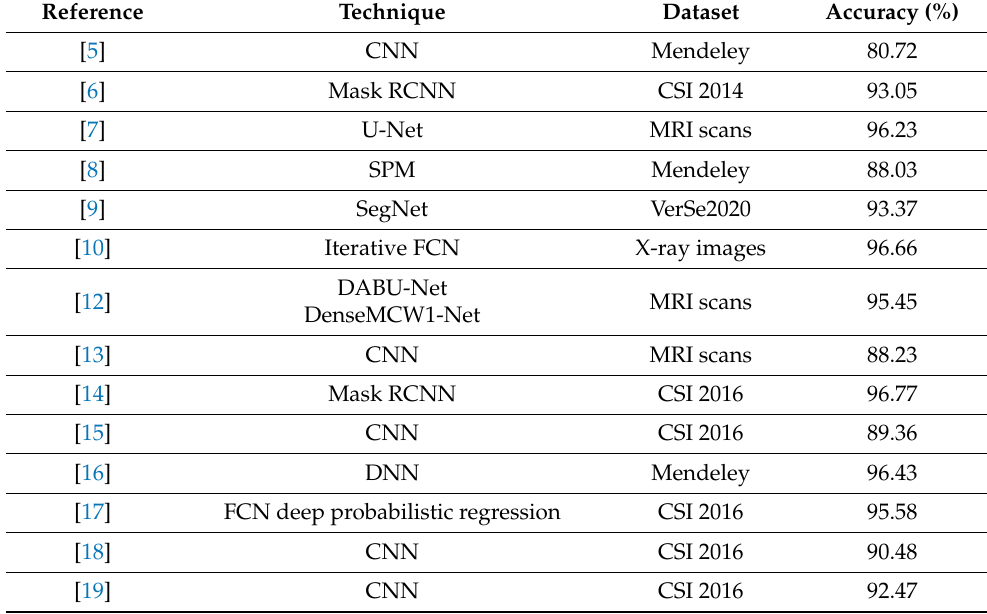
Table 1. Summary of